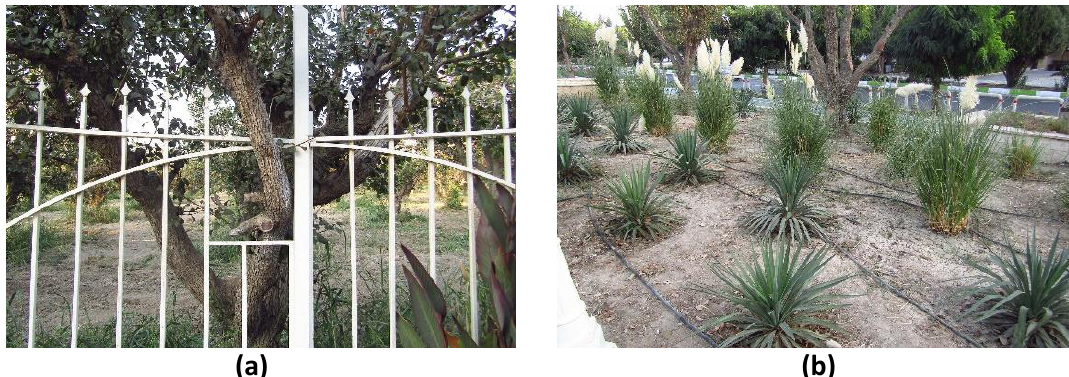
Fig. 8: (a) Preserving the trees during the process of constructing metal fences; (b) Newly planted shrubs are watered through drip irrigation